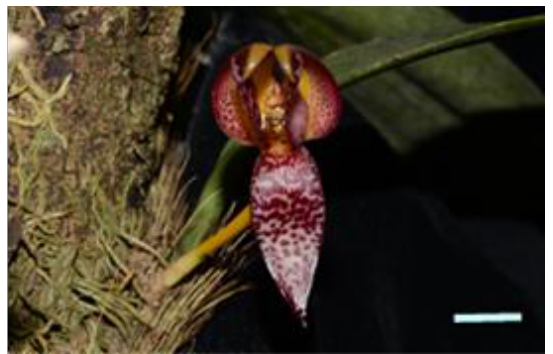
F IGURE 8. A Bulbophyllum praetervisum flower partially closed for the night. Note: a dead melon fly, Zeugodacus cucurbitae, still glued to the column. Bar: 1